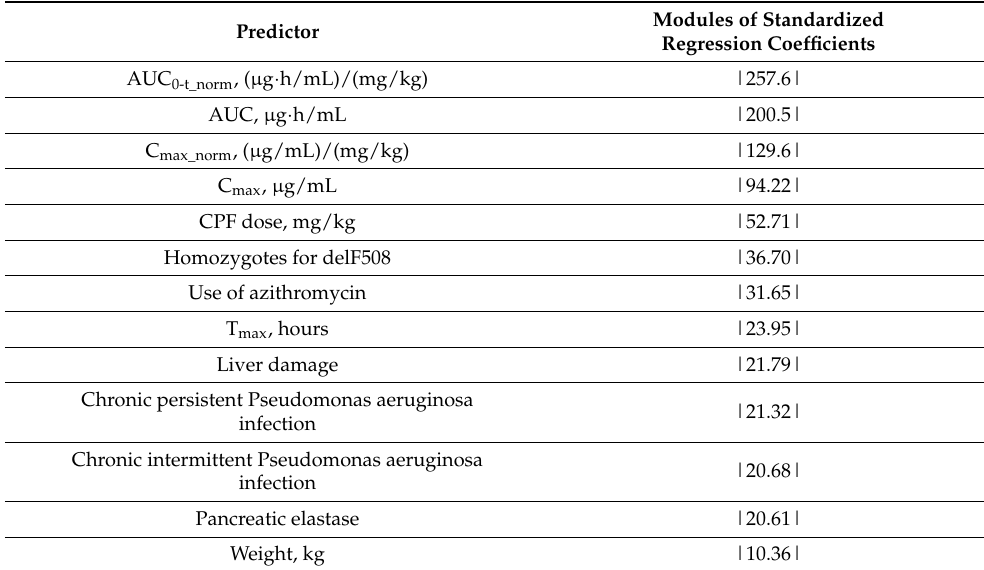
Table 12. Modules of standardized regression coefficients of predictors for the dependent variable “GSTP1 gene